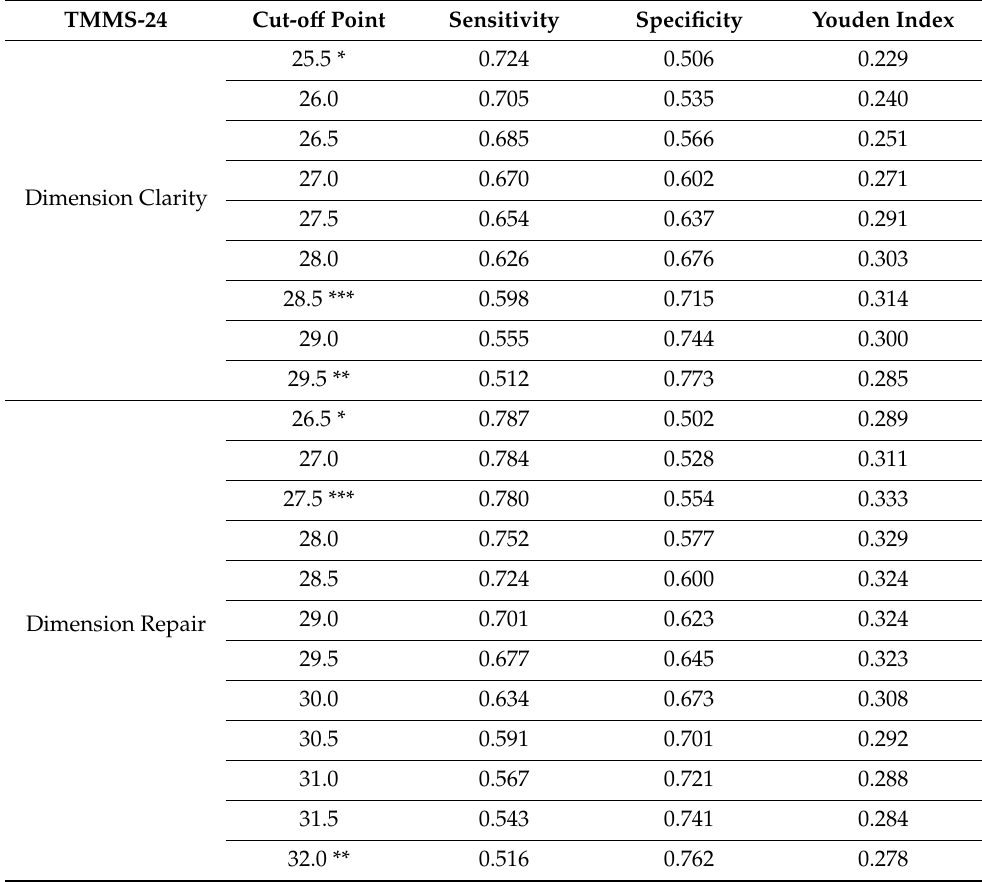
Table 4. Sensitivity, specificity and Youden Index for the scores of the clarity and repair dimensions in the